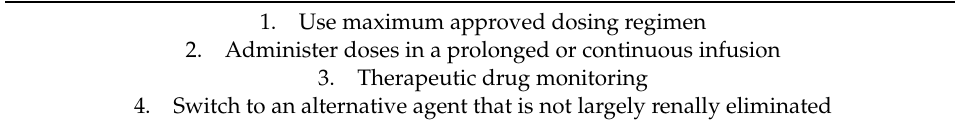
Table 2. Strategies for antibiotic use in patients with augmented renal